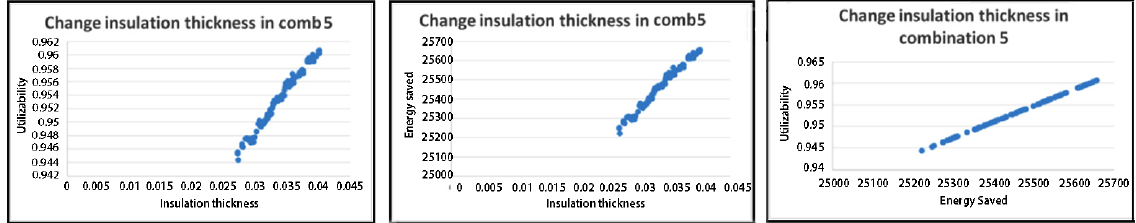
Fig. 9. Sensitivity analysis of wall insulation thickness in combination case